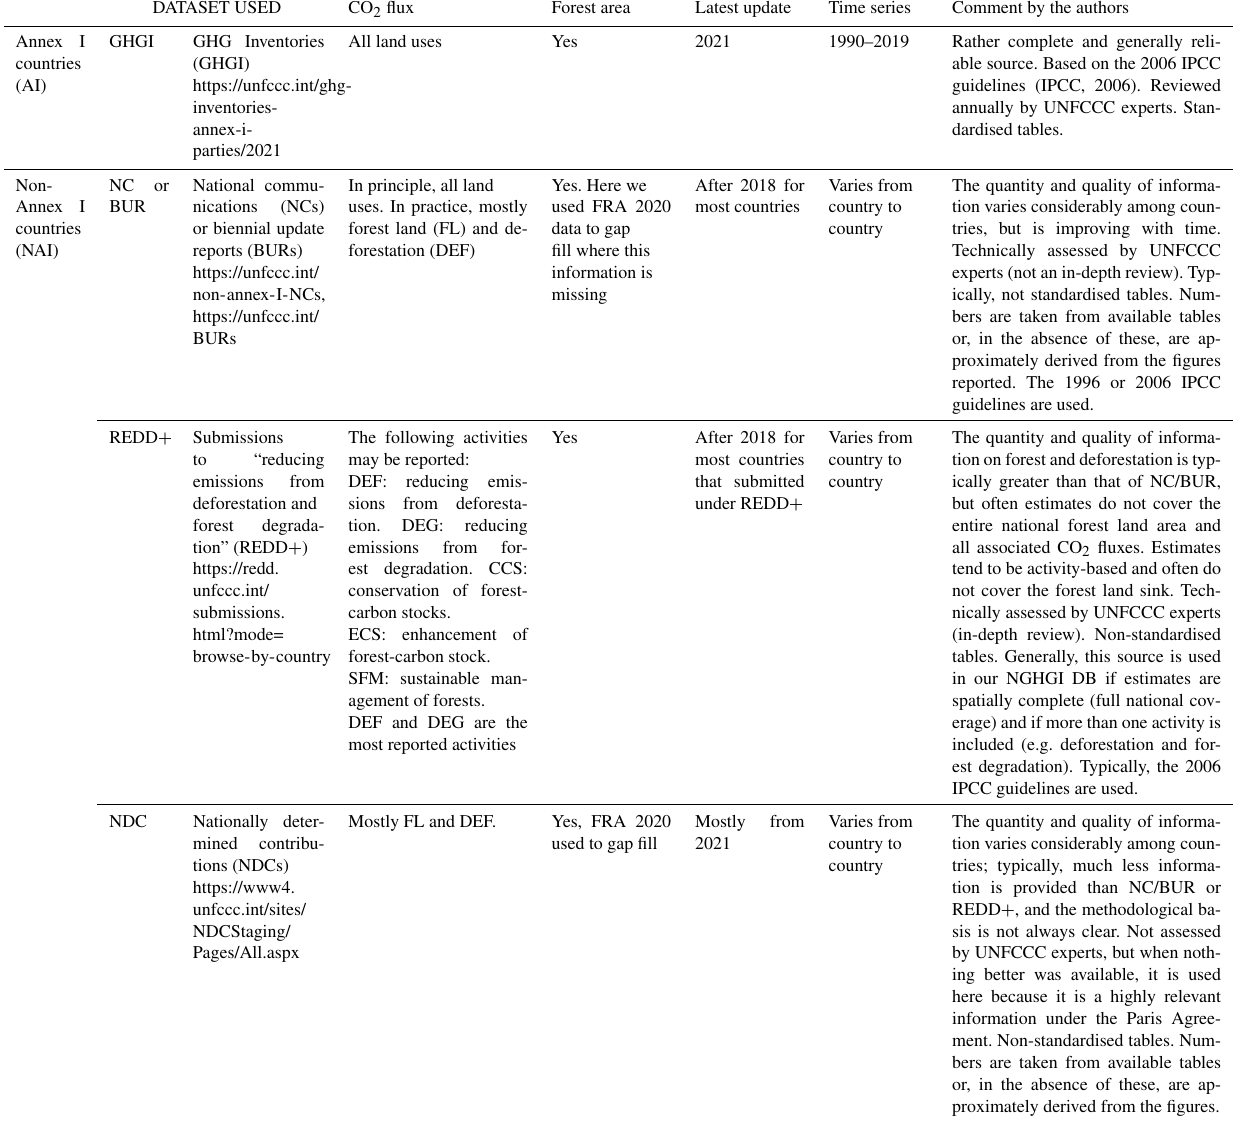
Table 1. Overview of the main characteristics of the sources of data used in this